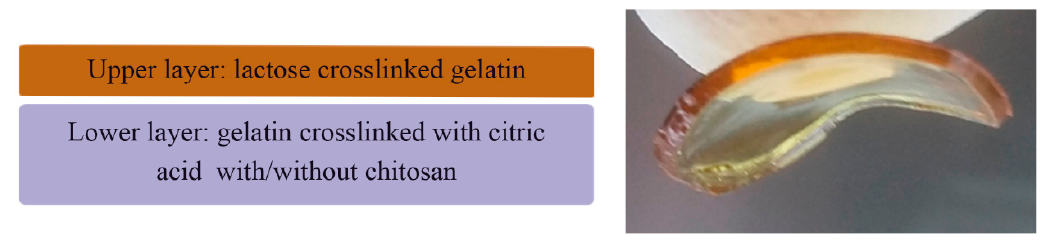
Figure 1. Scheme and photograph of gelatin bilayer films.